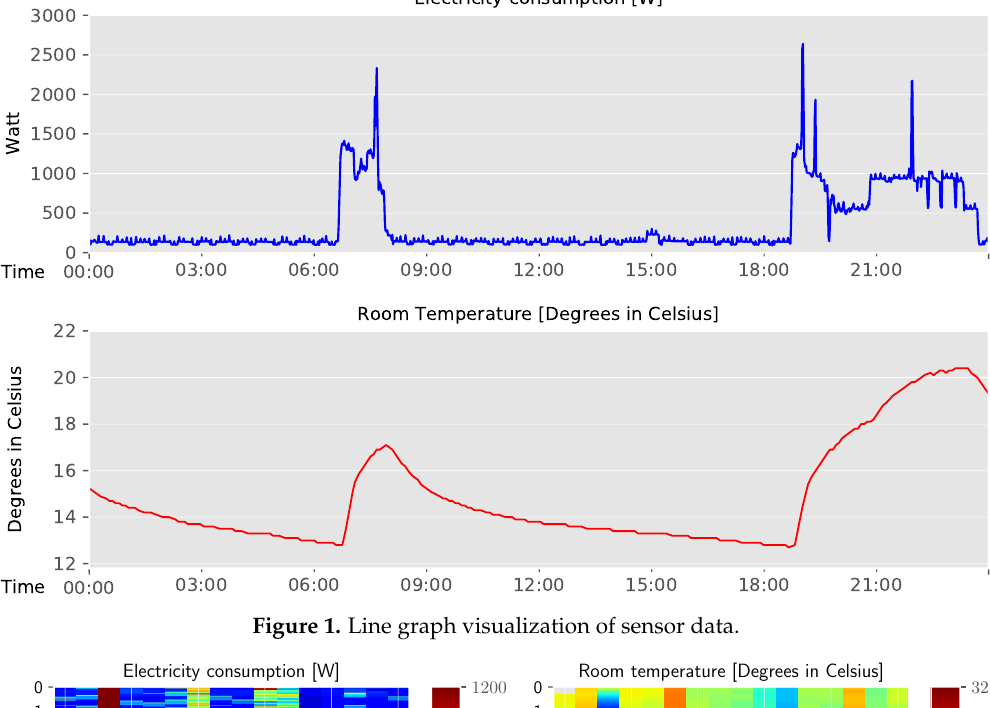
Figure 1. Line graph visualization of sensor data.